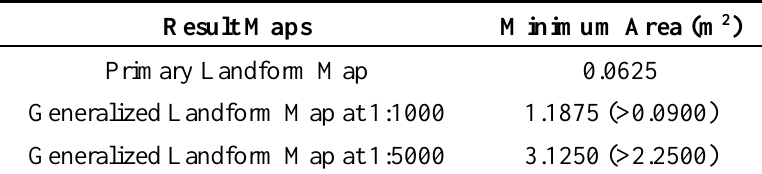
Table 2. Result landform maps and minimum areas.